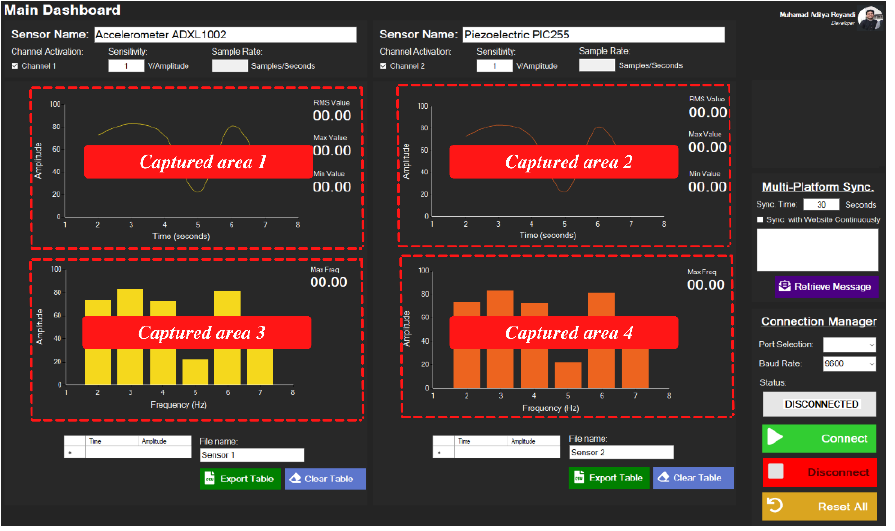
Figure 4. Main user interface in the Windows Forms app.